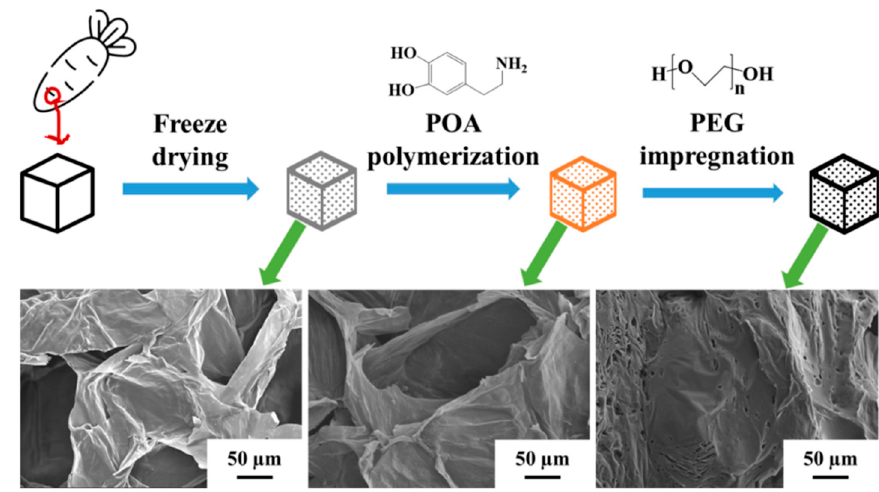
Figure 11. Preparation of composite PCMs with radishes and PEG [86].